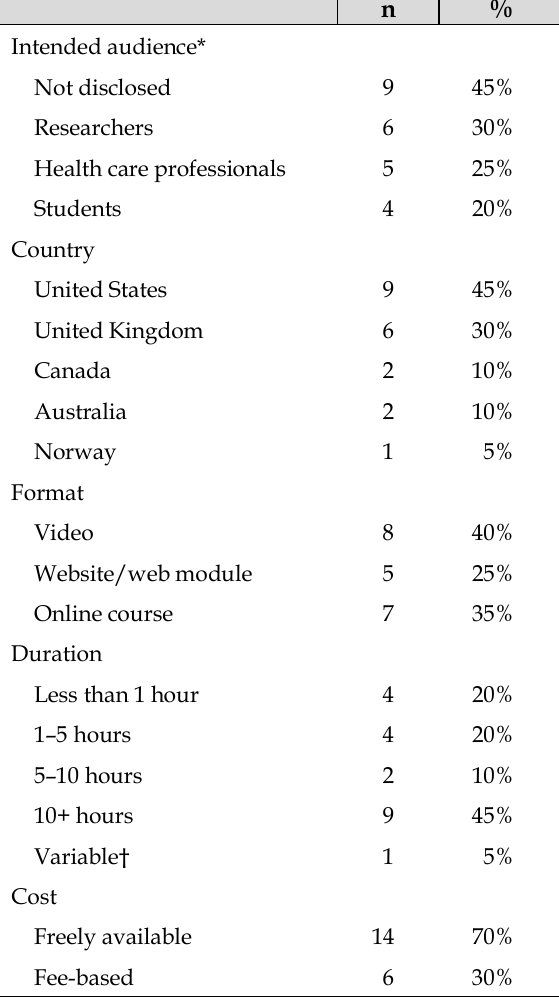
Figure 2 Overall scores (%) arranged by resource